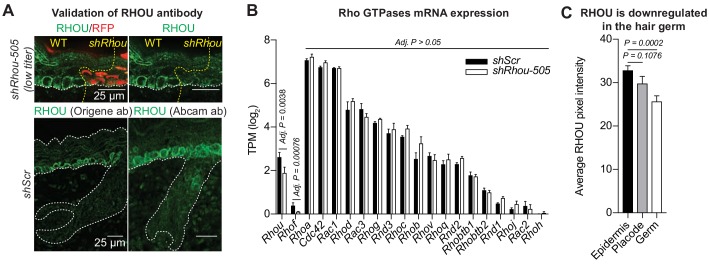
Validation of the shRhou knockdown and RHOU antibody specificity.(A) Validation of Rhou knockdown and specificity of anti-RHOU antibody for immunofluorescence. (Top panel): Shown is immunofluorescence of sagittal sections showing a shRhou-transduced and a non transduced region. (Bottom panel): RHOU expression pattern in the skin was confirmed using a second antibody. Scale bars, 25 μm (B) Differential gene expression analysis using DESeq2 shows that a dozen other Rho GTPases, including closely related Rhov, which were expressed in the skin epithelium at comparable or higher levels than Rhou, showed no change in expression levels in RHOU-deficient skin. (C) Quantifications of RHOU mean pixel intensity in the epidermis, placode and hair germ. Error bars represent SEM from n = 14 epidermis regions, n = 10 placodes, n = 10 hair germs. Normal distribution of the data was determined using the Shapiro-Wilk test. Parametric independent two-tailed unpaired t-test was used to compare the data.